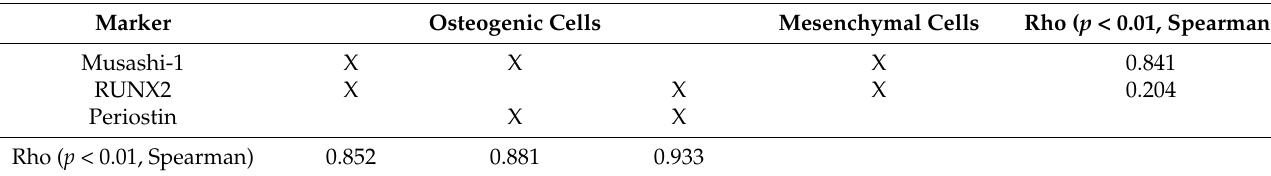
Table 2. Correlations between the expression of the different markers under study at day 14.